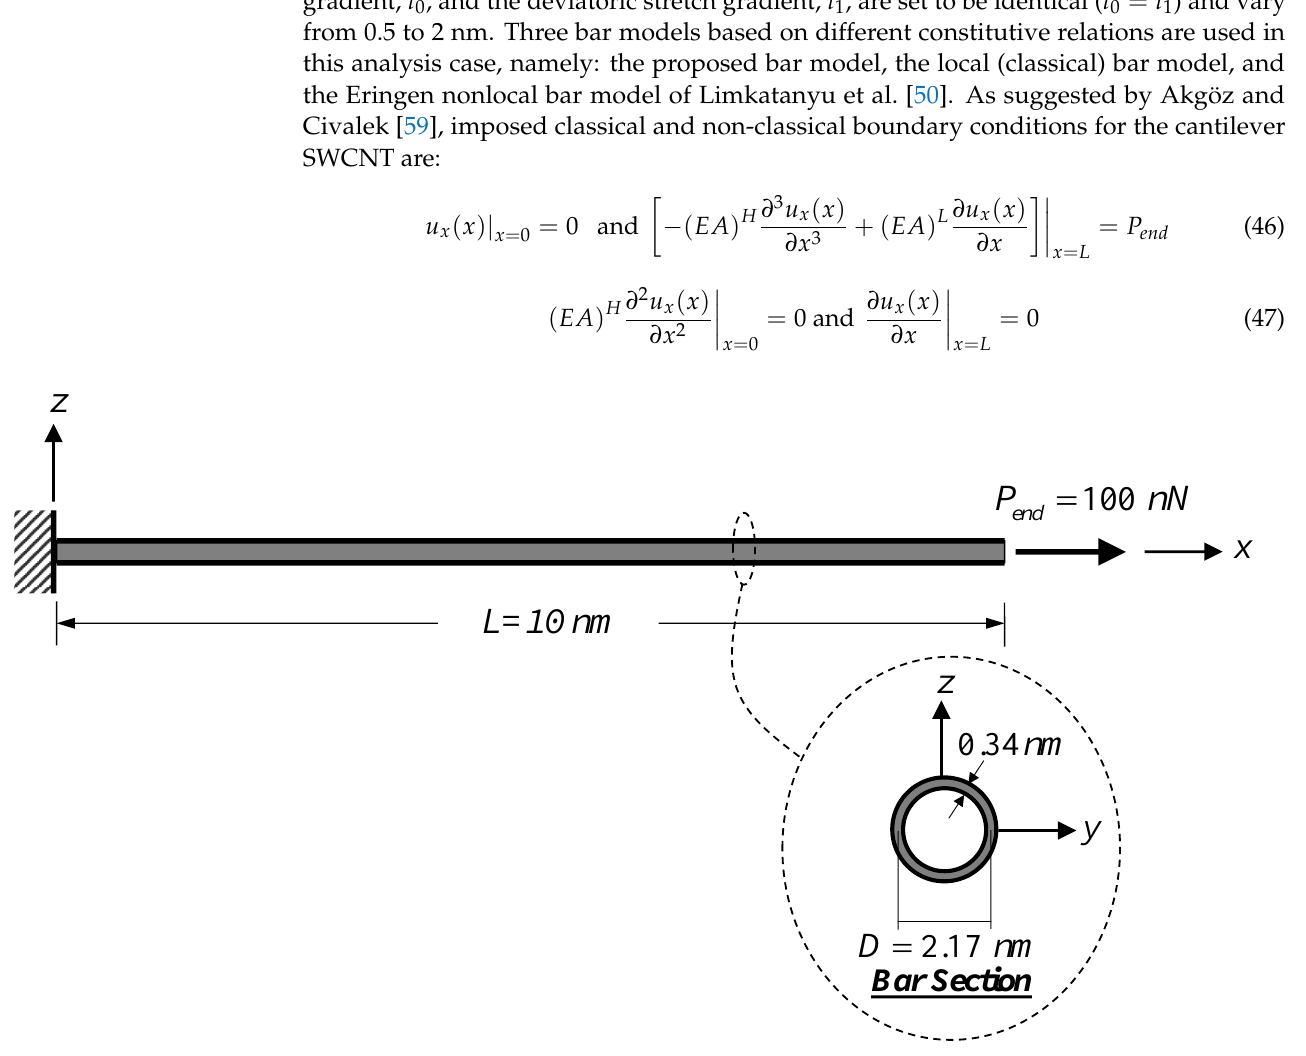
Figure 4. Cantilever SWCNT subjected to a constant axial-force state: static analysis.